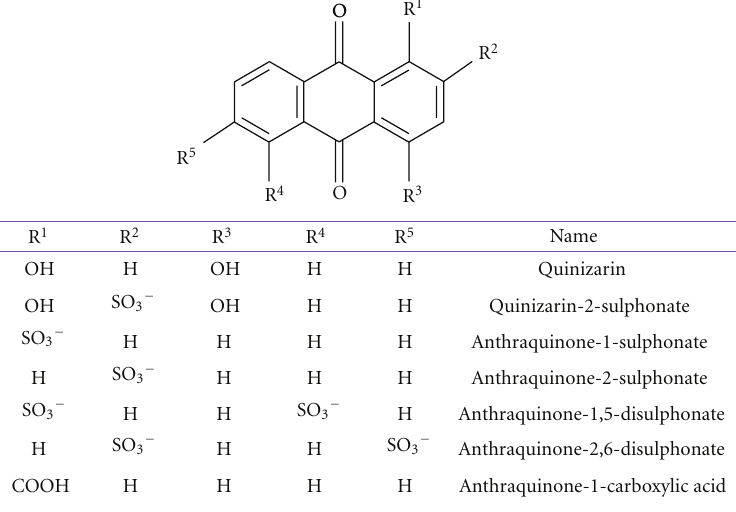
Scheme 4: Structures of di ff erent